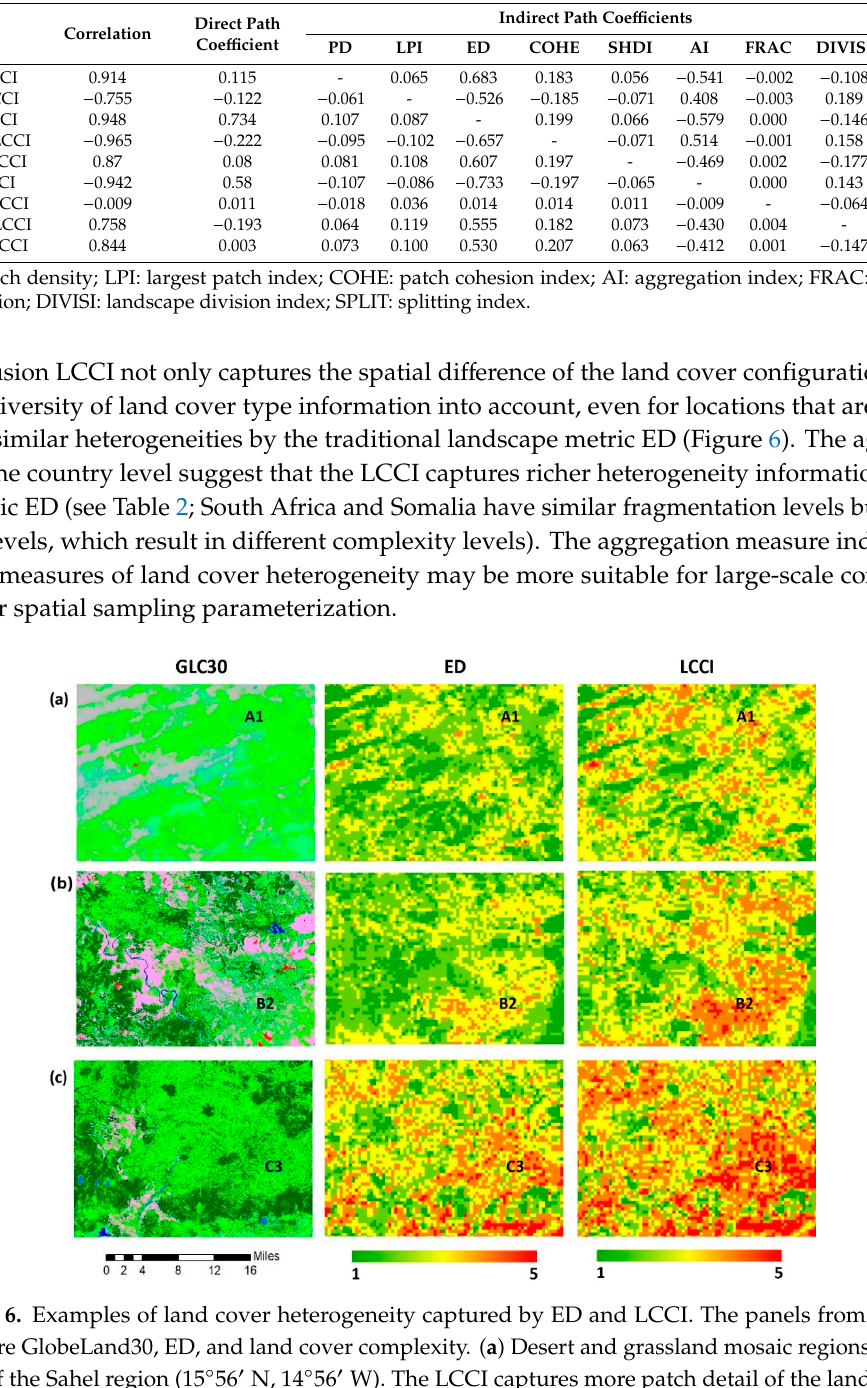
Table 1. Correlation and path coe ffi cients between Land Cover Complexity Index (LCCI) and landscape metrics.